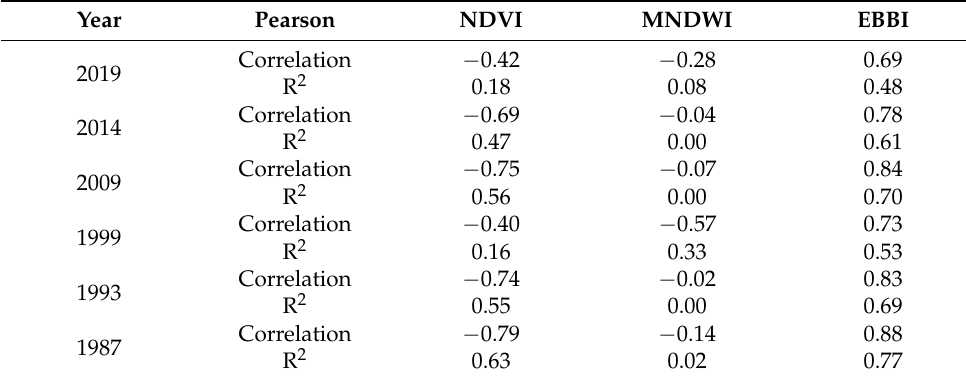
Table 5. Correlation between the LST and the EBBI, MNDWI and NDVI indices per year in the study area.